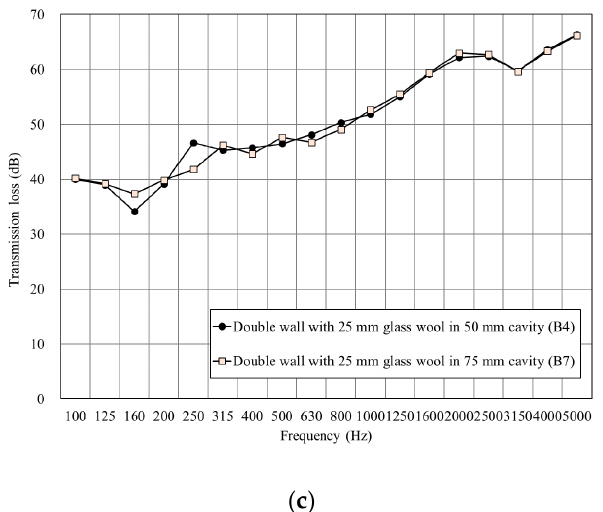
Figure 7. The sound insulation performance of the double wall: ( a ) Comparison of the test specimens with different cavity thicknesses. ( b ) Comparison of the test specimens with different glass wool thicknesses. ( c ) Comparison of the test speci- mens with different cavity thicknesses but the same thickness of glass wool.